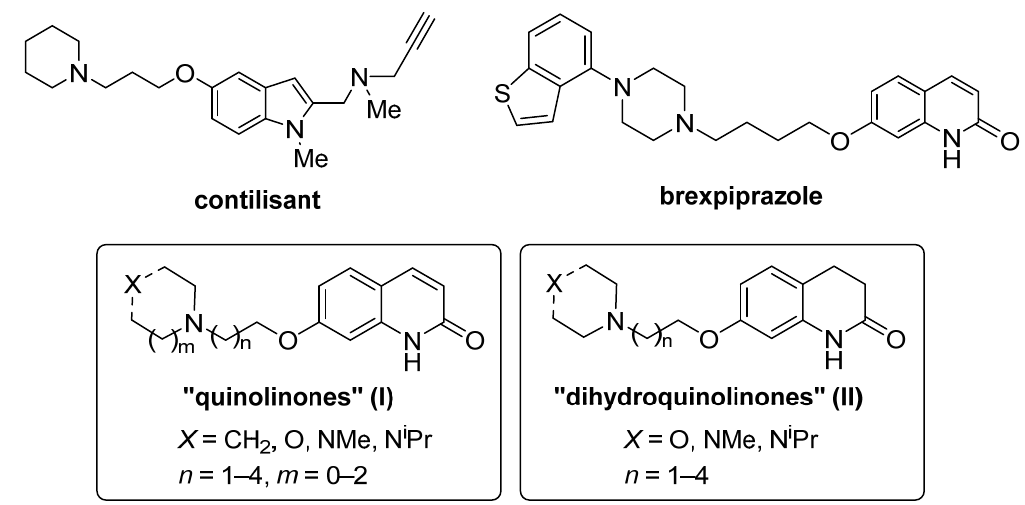
Figure 1. Structure of contilisant, brexpiprazole, “quinolinones” (I), and “dihydroquinolinones” (II), the new MSM designed in this work.